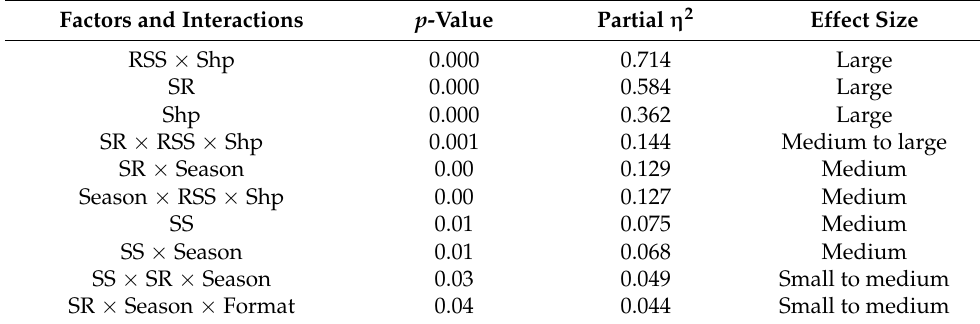
Table 6. Summary of the ANOVA results (N = 144) indicating those significant factors and interac- tions ( p < 0.05) together with their associated partial η 2 . Notes: reflectance storage scale (RSS); shape parameter category (Shp); spatial resolution (SR); study site (SS).